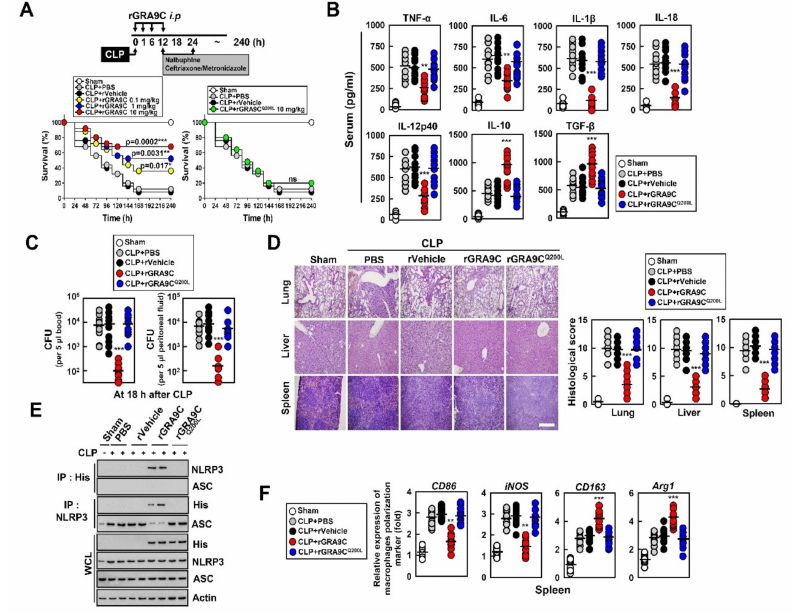
Figure 6. rGRA9C prevents mice from CLP-induced septic shock. ( A ) Schematic of the CLP model treated with PBS, rVehicle, rGRA9 at the indicated concentrations or rGRA9C Q200L (upper). The survival of mice was monitored for 240 h; mortality was measured for n = 25 mice per group (lower). Statistical di ff erences compared with the rVector-treated mice are indicated (log-rank test). The data are representative of two independent experiments with similar results. ( B ) Serum cytokine levels from 18 h after treatment of CLP mice with PBS, rVehicle, rGRA9C, or rGRA9C Q200L per group ( n = 10 mice per group). ( C ) The bacterial burden was evaluated 18 h after treatment of CLP mice with PBS, rVehicle, rGRA9C or rGRA9C Q200L ( n = 10 mice per group). ( D ) Representative hematoxylin and eosin (H&E) staining of the lung, liver and spleen (left) ( n = 10 mice per group). Histopathology scores were obtained from H and E stained as described in methods (right) were determined at 30 h in CLP mice were treated with PBS, rVehicle, rGRA9, or rGRA9C Q200L . Scale bar, 500 µ m. ( E ) Splenocytes were used for immunoprecipitation (IP) with α His or α NLRP3, followed by immunoblotting (IB) with α NLRP3, α ASC or α His. WCLs were used for IB with α His, α NLRP3, α ASC or α Actin. The data are representative of three independent experiments with similar results. ( F ) Splenocytes were used for quantitative real-time PCR with M1 (CD86 and iNOS) or M2 (CD163 or Arg1) macrophage polarization marker. Significant di ff erences (* p < 0.05, ** p < 0.01; *** p < 0.001) compared with rVector-treated mice ( A – C , D right, and F ). Full-length images of the blots presented in the Figure